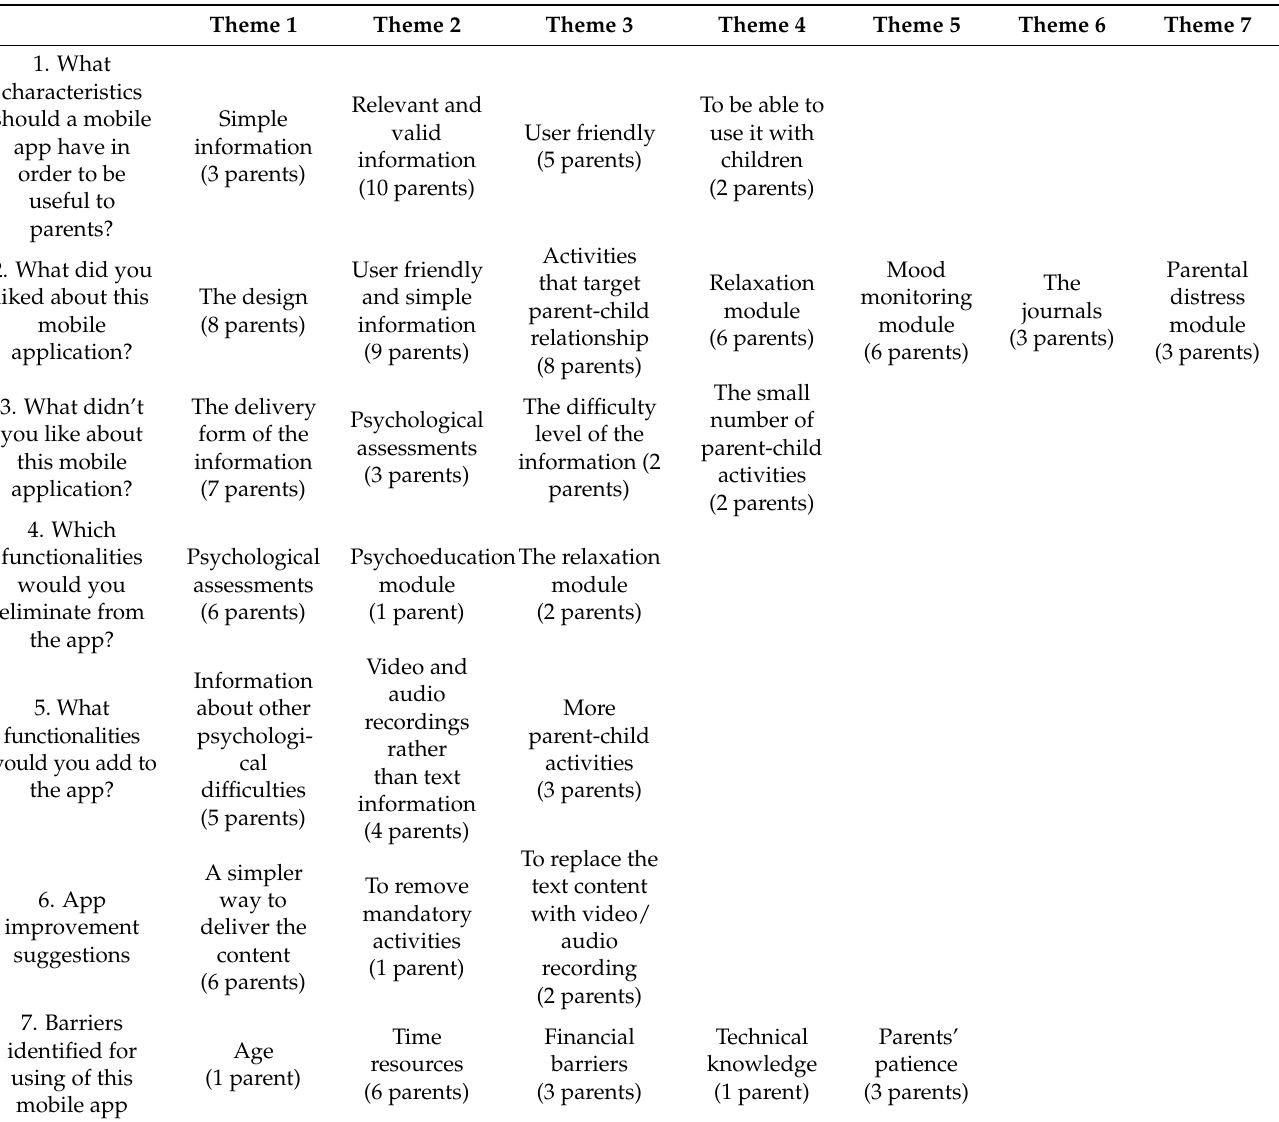
Table 1. Descriptive data about parents’ feedback on ADHD Coping